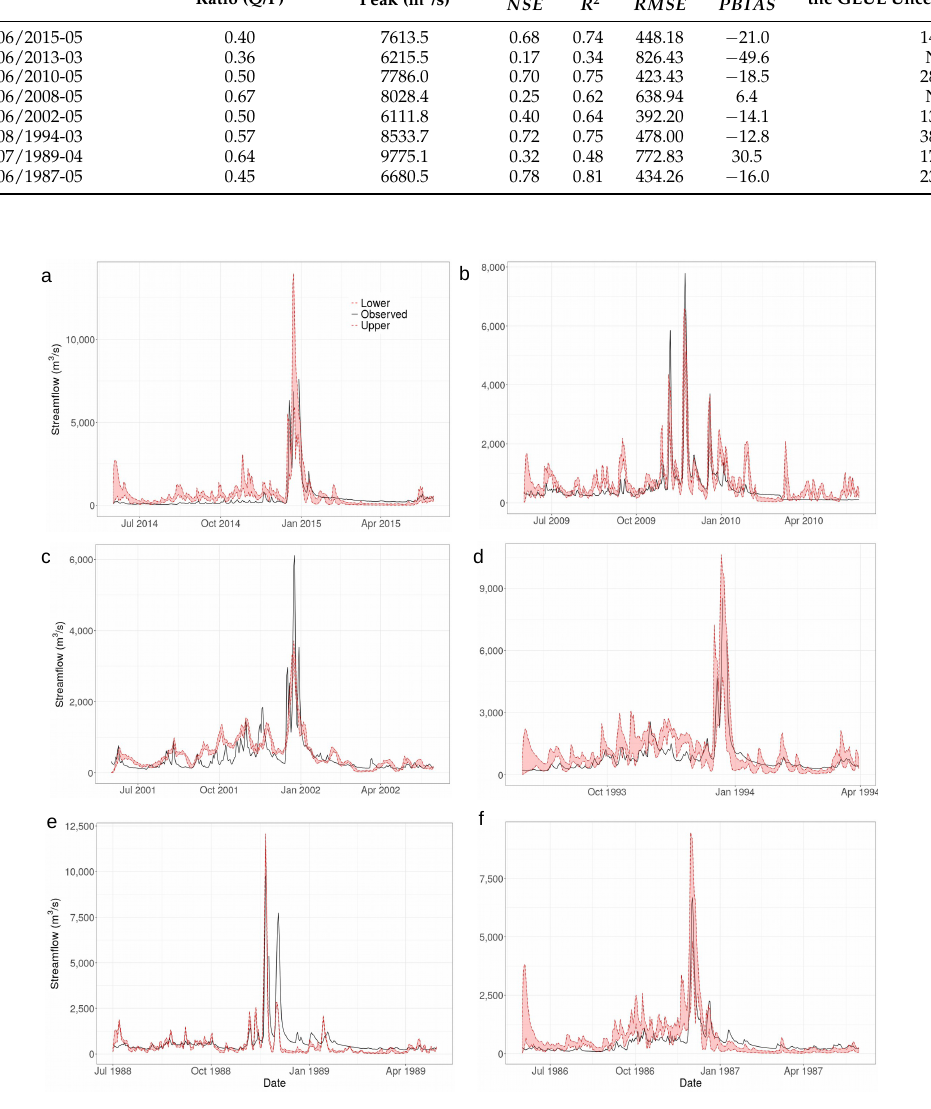
Figure 4. The observed and the GLUE uncertainty boundary. ( a ) Peak 1, ( b ) Peak 3, ( c ) Peak 5, ( d ) Peak 6, ( e ) Peak 7, ( f ) Peak